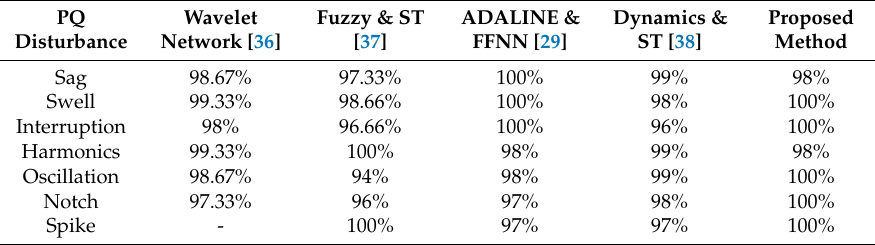
Table 4. The accuracy comparison of specific events of the proposed method and other